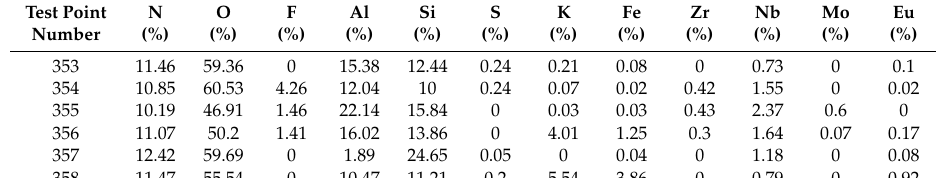
Figure 8. High-magnification SEM analysis of the center part of the sample leached with (NH 4 ) 2 SO 4 solution for 1 h. ( a – c ): SEM images with 2000 ( a ), 20,000 ( b ) and 50,000 ( c ) magnifications.